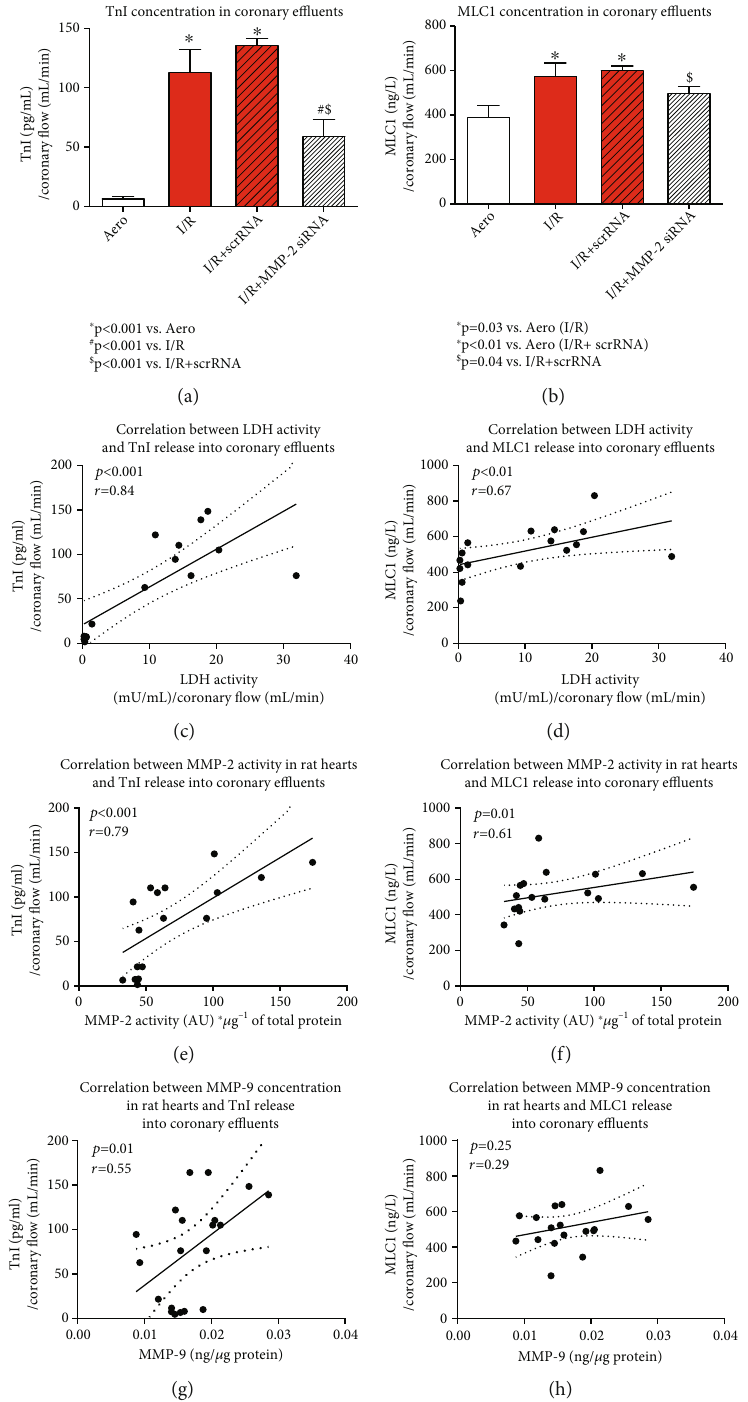
Figure 5: TnI (a) and MLC1 (b) release into coronary e ffl uents. Correlation between LDH activity and TnI (c) and MLC1 (d) release. Correlation between MMP-2 activity and TnI (e) and MLC1 (f) release into extracellular space. Correlation between MMP-9 synthesis in rat hearts and TnI (g) and MLC1 (h) release into coronary e ffl uents. Straight line: standard curve; dotted line: 95% con fi dence band. Aero: aerobic control group; I/R: ischemia/reperfusion; LDH: lactate dehydrogenase; MLC1: myosin light chain 1; MMP-2: matrix metalloproteinase 2; TnI: troponin